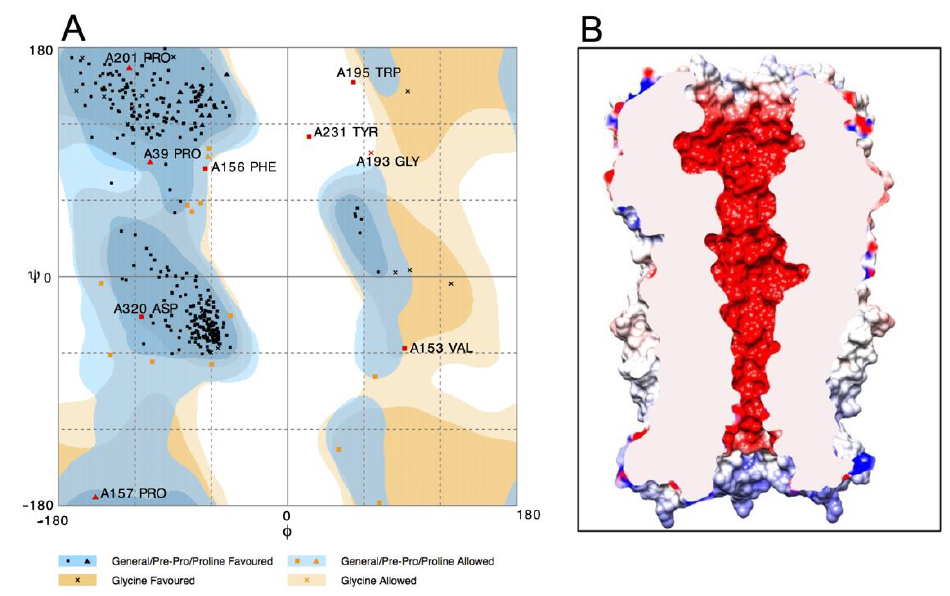
Figure 3. ( A ) Ramachandran plot of the rat α7 nAChR model generated by the RAMPAGE server. ( B ) Electrostatic potential of the α7 nAChR. The electronegative region is illustrated in red whereas electropositive is illustrated in blue (values scale is shown in ±10 kT/e).